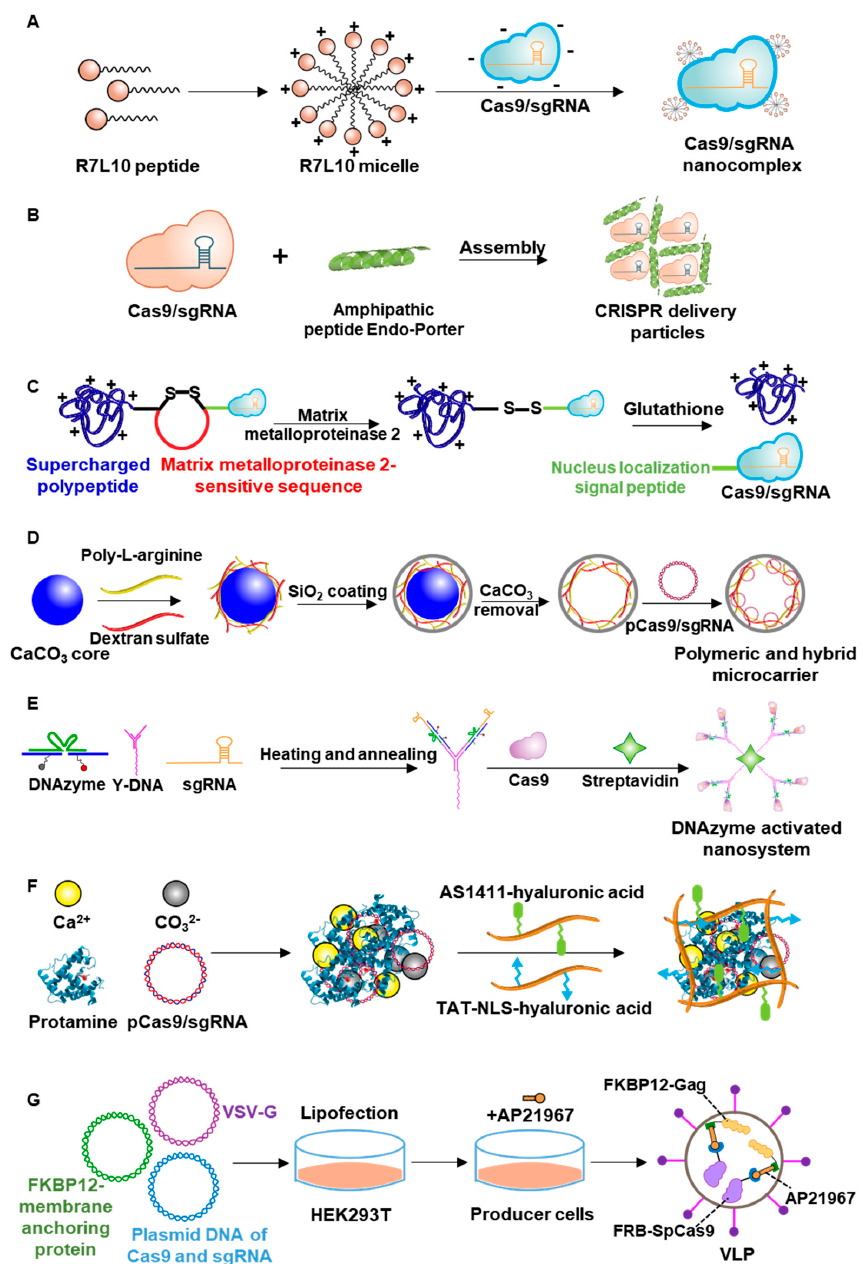
Figure 5. Peptide / protein-based systems for delivery of genome-editing components. ( A ) R7L10-based micelle for delivery of Cas9 ribonucleoprotein (RNP) complexed with sgRNA. Adapted from [44]. Nature Publishing Group, 2019 ( B ) Amphipathic peptide-based nanocomplexes for delivery of Cas9 ribonucleoprotein complexed with sgRNA. Adapted from [45], ASBMB, 2018. ( C )